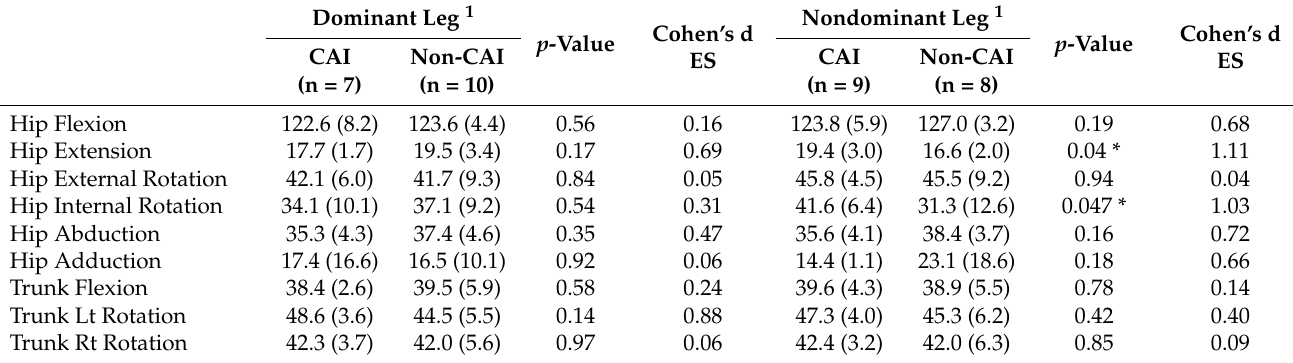
Table 4. Hip and trunk measurements of the dominant and the nondominant legs in the CAI and non-CAI